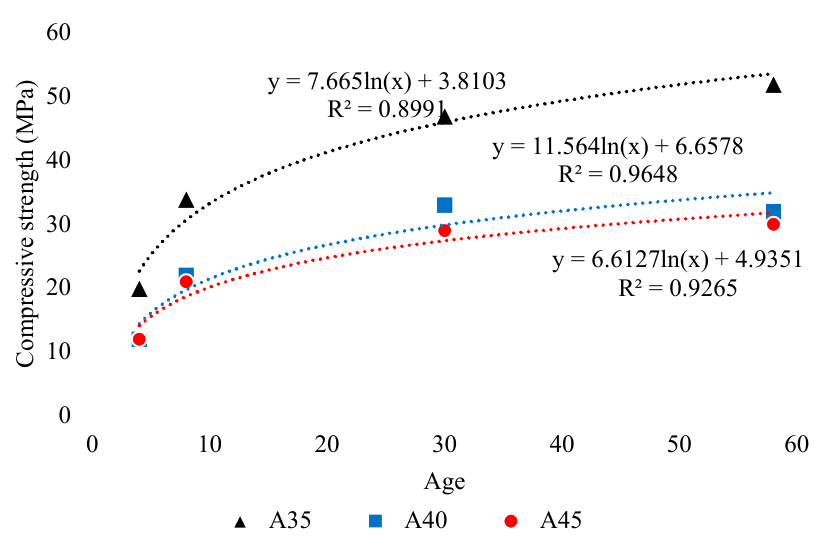
Figure 24. Effect of activator content on compressive strength, adopted from [38]; Elsevier, 2014.